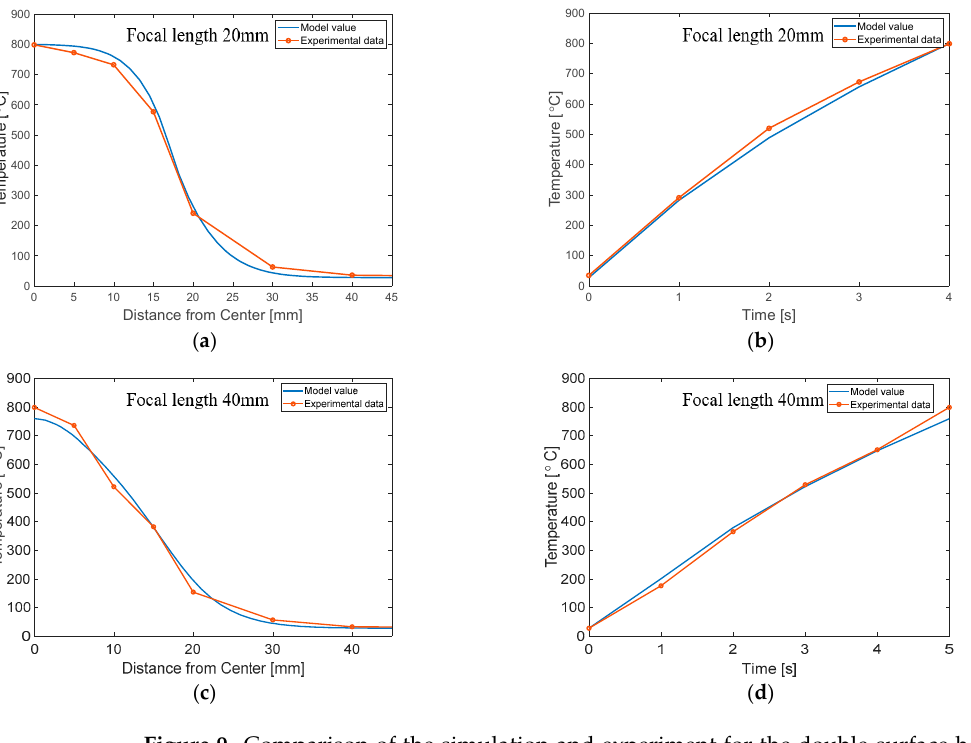
Figure 8. Comparison of the simulation and the experiment for the single-surface heating: ( a ) Tem- perature profile of the target material for the 20 mm focal length; ( b ) Heating rate at the center for the 20 mm focal length; ( c ) Temperature profile of the target material for the 40 mm focal length; ( d ) Heating rate at the center for the 40 mm focal length.